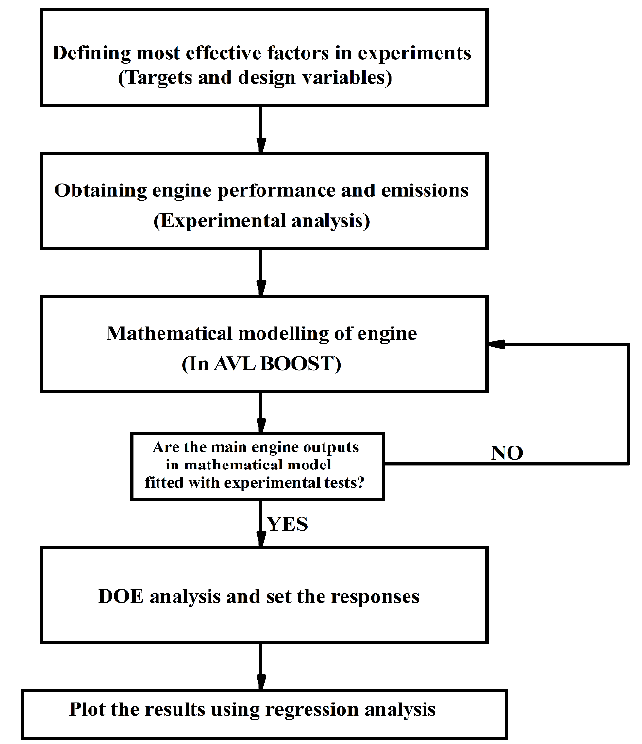
Figure 5. The research method flow chart proposed in this paper.